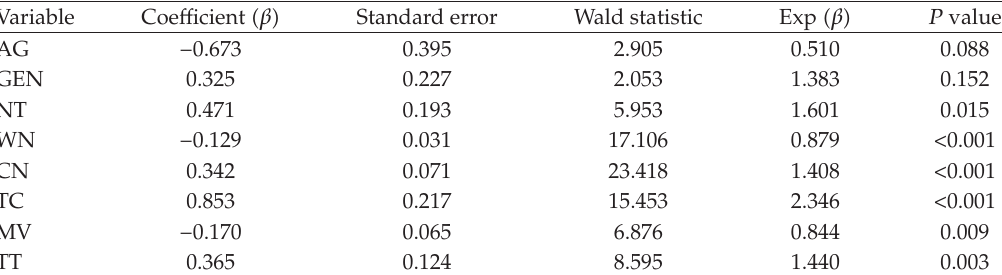
Table 2: Estimation in waiting duration